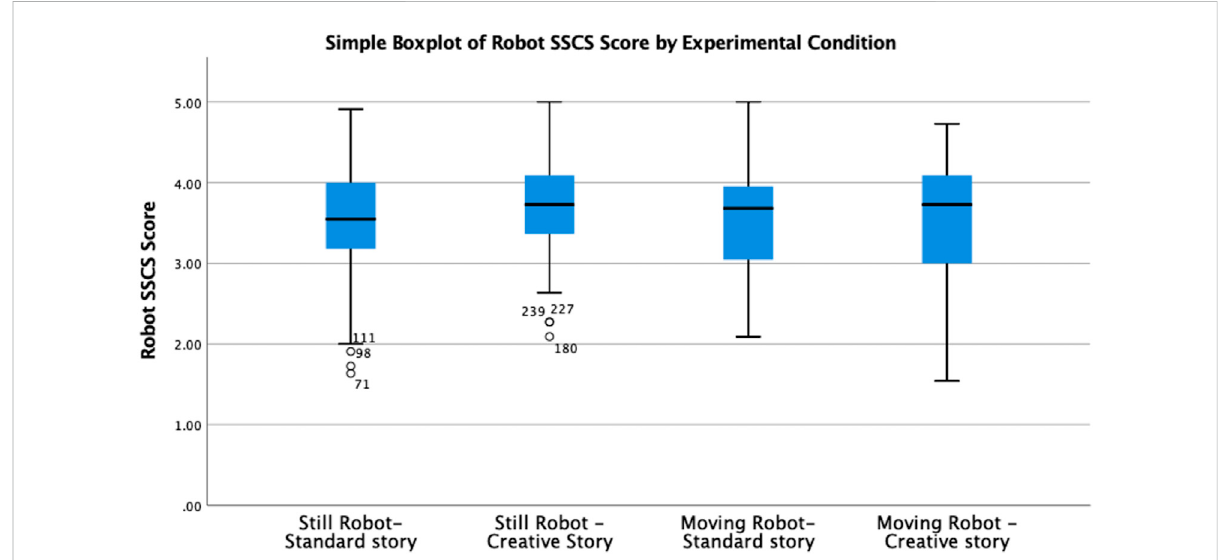
FIGURE 4 Boxplot per group of the SSCS applied to the robot with outliers. No signi fi cant differences were found among the means of the